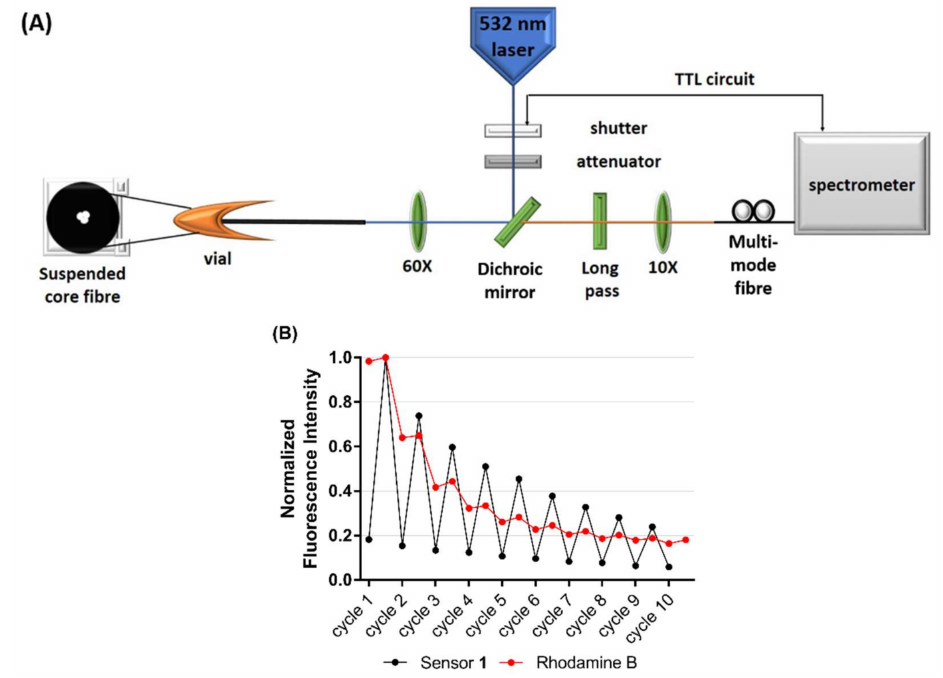
Figure 4. ( A ) Schematic of the optical setup used to measure fluorescence from a suspended core microstructured optical fibre (SCF). ( B ) Photostability of chemosensor 1 (500 µ M) in the presence of Mg 2+ (1 mM) (black), compared to the photostability of Rhodamine B (red) in an SCF. Excitation was at 532 nm, with 10 × 50 ms pulses at 1 mW power. Results are normalised to the highest fluorescence measurement,